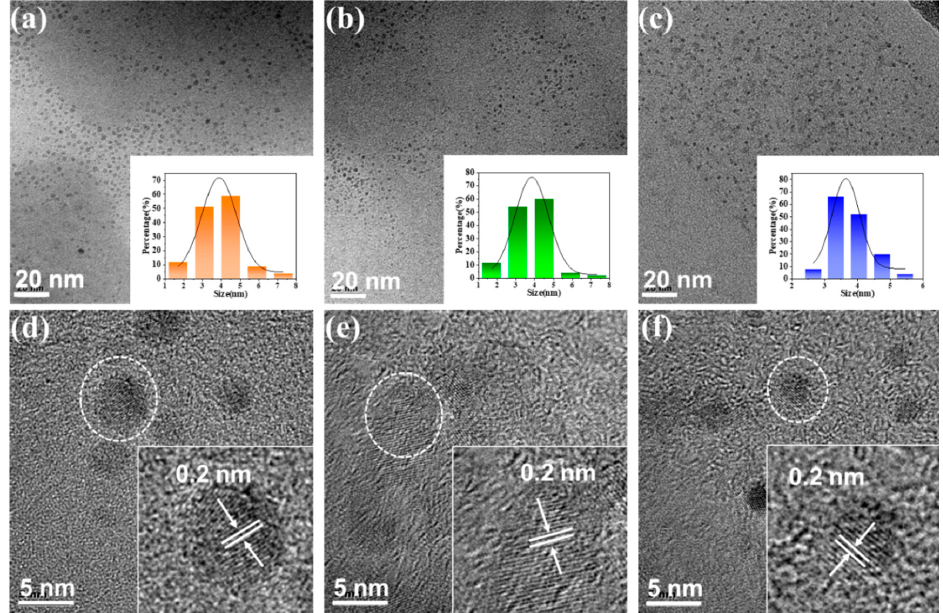
Figure 6. ( a – c ) TEM images of R-CDs to B-CDs. ( d – f ) High-resolution TEM (HRTEM) images of R-CDs to B-CDs. (Insets: HRTEM images and particle size distributions).